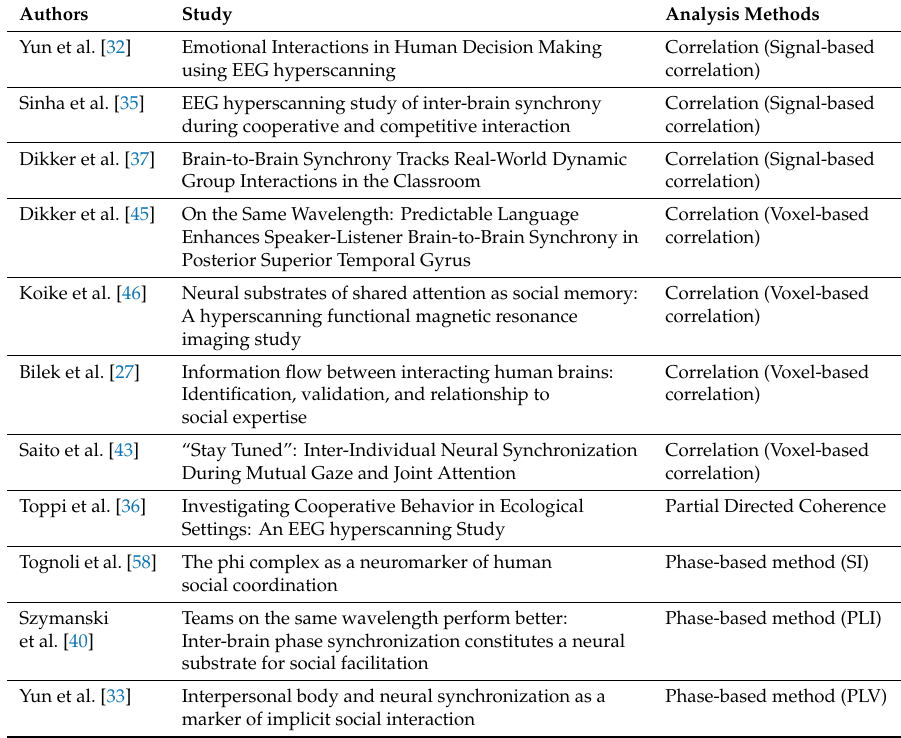
Table 3. A list of the analysis techniques used for analysing neural (objective) data. PLI =